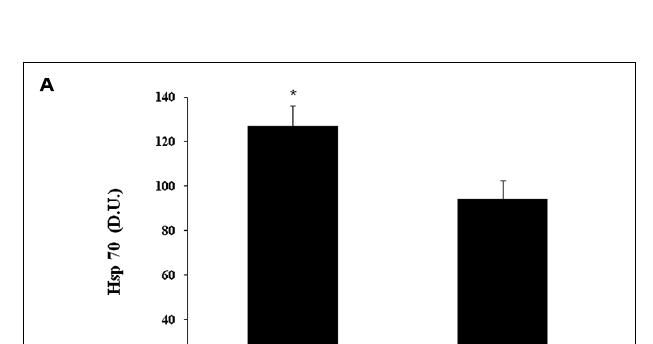
Table 1 | Clinical data of glaucoma patients and control subjects. Number of subjects Age (Mean ± SD) Patients Controls 20 0.8 ± 0.3